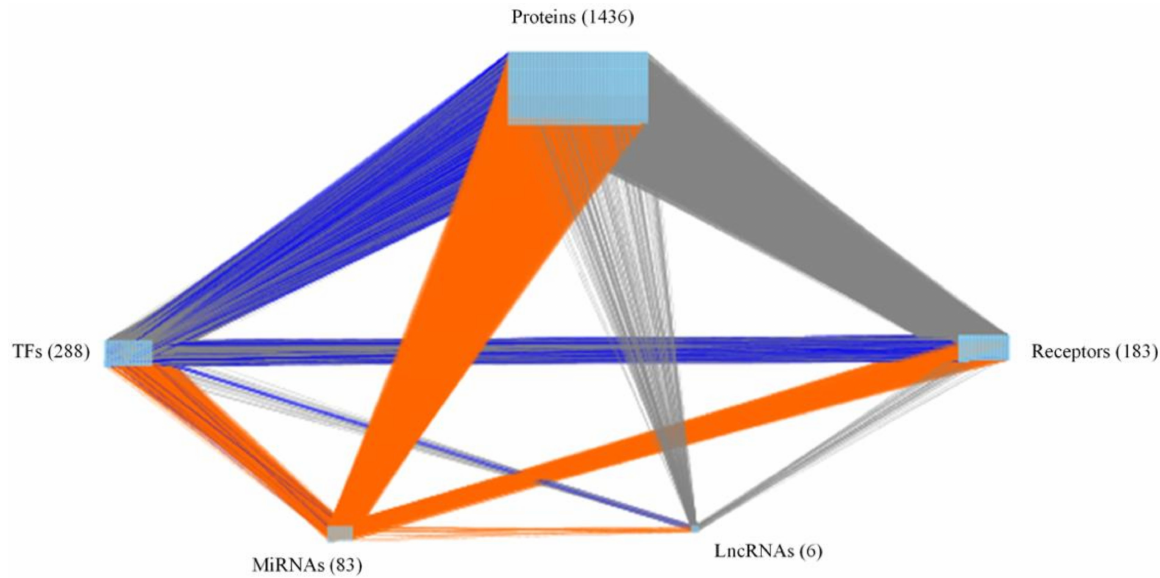
Figure 1. The core genome-wide genetic and epigenetic network (GWGEN) of TNBC. The grey lines indicate protein–protein interactions (PPIs); the blue lines denote transcriptional regulations by TFs and lncRNAs; and the orange lines represent post-transcriptional regulations by miRNAs. The numbers of receptors, proteins, TFs, miRNAs, and lncRNAs are 183, 1436, 288, 83, and 6,